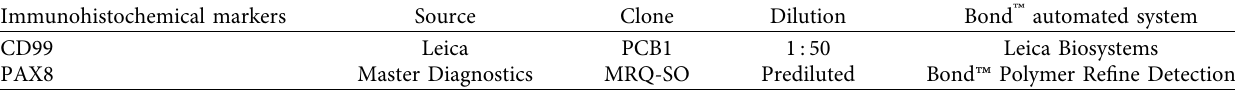
Table 2: Immunohistochemistry methods.